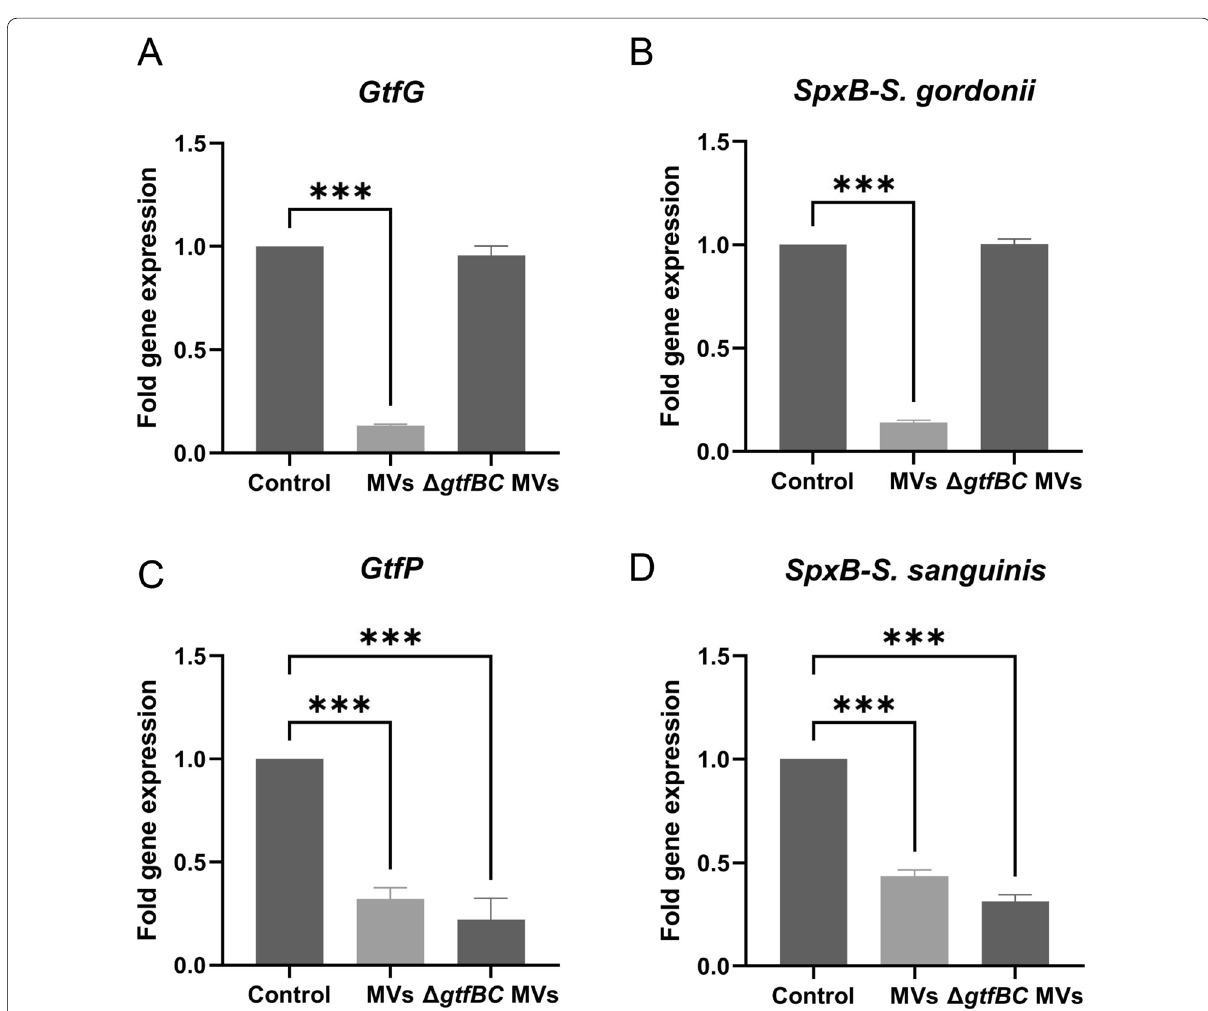
Fig. 4 Effects of MVs on virulence genes of S. gordonii and S. sanguinis . A GtfG , B SpxB in S. gordonii , C GtfP , D SpxB in S. sanguinis . The data are presented as mean SD from three independent experiments (n ±